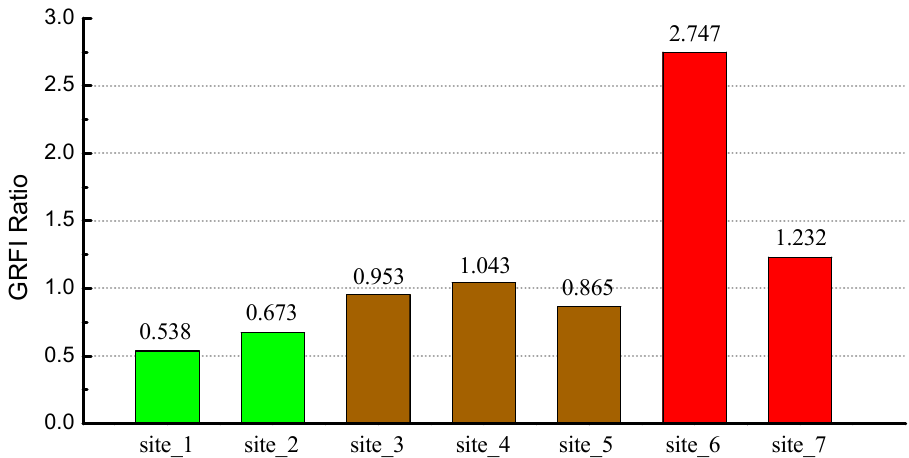
Figure 9. The ratio of rice growth rate fluctuation (GRFI Ratio) in different study sites.